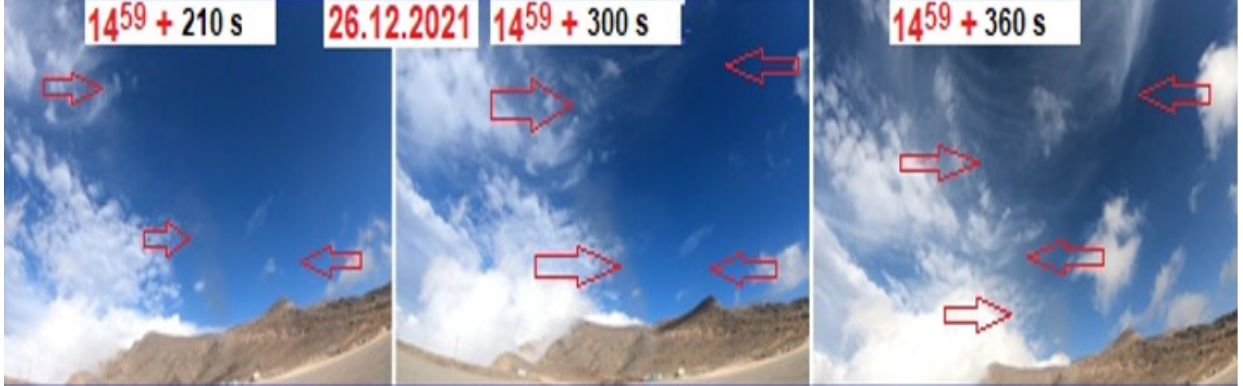
Figure 10. Convergence of clouds in the direction of the jet. The engine was turned on at 14:59 local time, leap seconds show the time elapsed since the start of experiment.